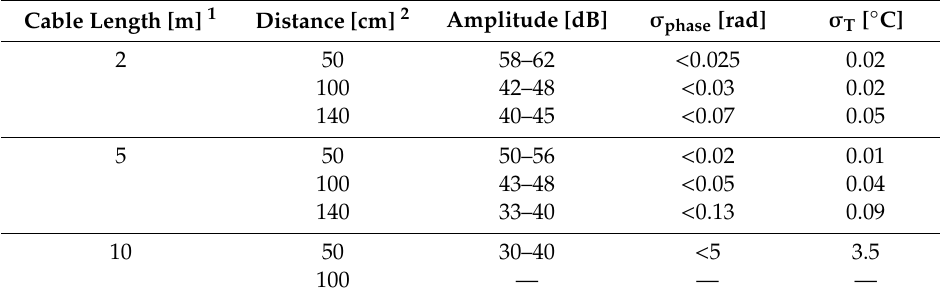
Table 3. Range measurements with FMCW reader, averaging = 100 and 9 dBi